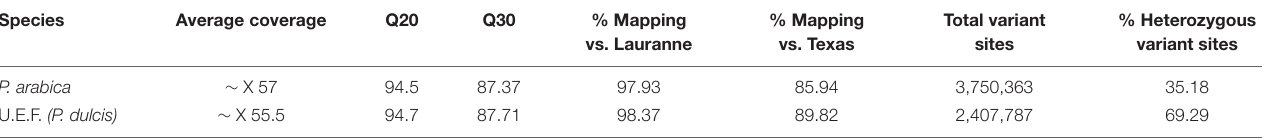
FIGURE 2 | Stem photosynthetic capability (SPC) in the F1 progeny. Levels of net CO 2 assimilation for each offspring (A) . Each box plot presents the average of four stems ( n = 4). The F1 progeny parents, P. arabica and U.E.F. are marked by dashed arrow and simple arrow, respectively. Distribution histogram of the same data is presented in (B) , while parents’ data are highlighted. Measurements were conducted during February 2020, while the trees were dormant. Representative pictures of the F1 population while dormant (C) in February, and during the vegetative phase in April (D) . TABLE 1 | Quality data from whole-genome sequencing of P. arabica and U.E.F.